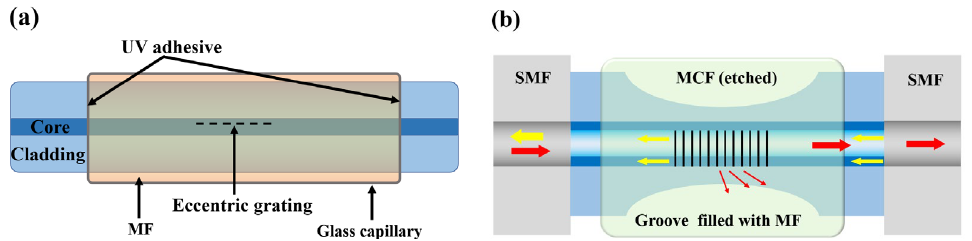
Figure 6. Magnetic field fiber sensors based on ( a ) EFBG [48] and ( b ) MCF [49].